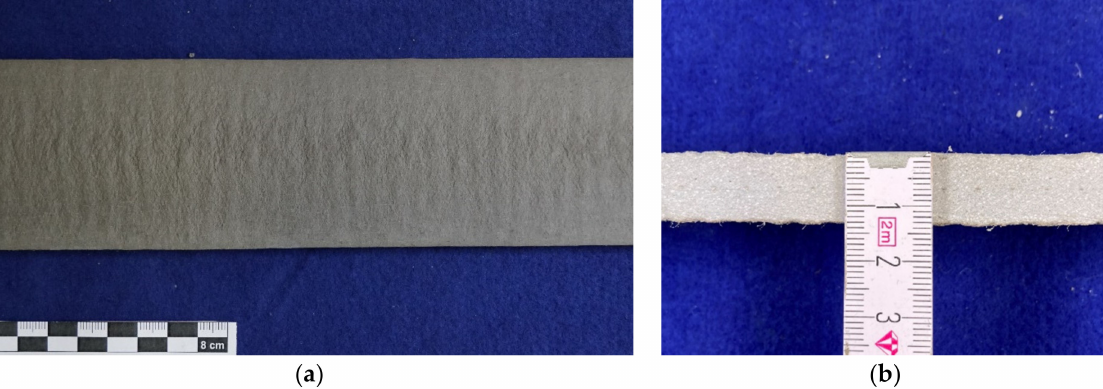
Figure 10. ( a ) Surface of extruded glass textile mortar; ( b ) Cross-section of the extruded glass textile